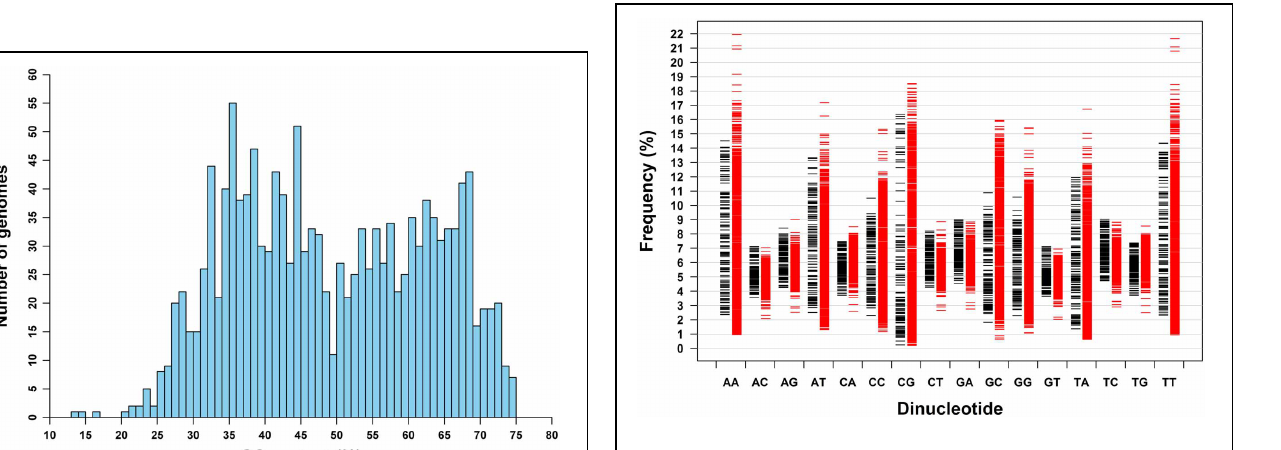
FIGURE 2 | Dinucleotide frequency distribution patterns of 133 archaeal genomes and 1309 bacterial genomes. Each genome is represented by a dash (black dash, archaeal genome; red dash, bacterial